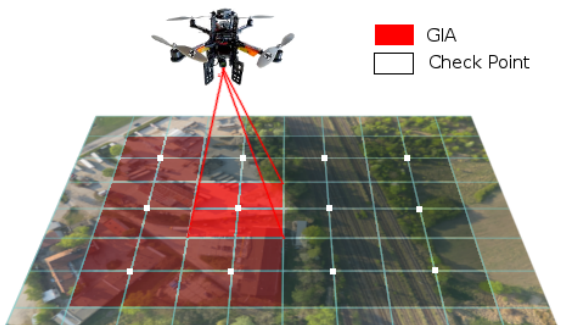
Figure 2: Example of UAV flight planning. Using a desired over- lapping and a GSD value, a GIA is defined. Grid path is formed linking check points optimally.